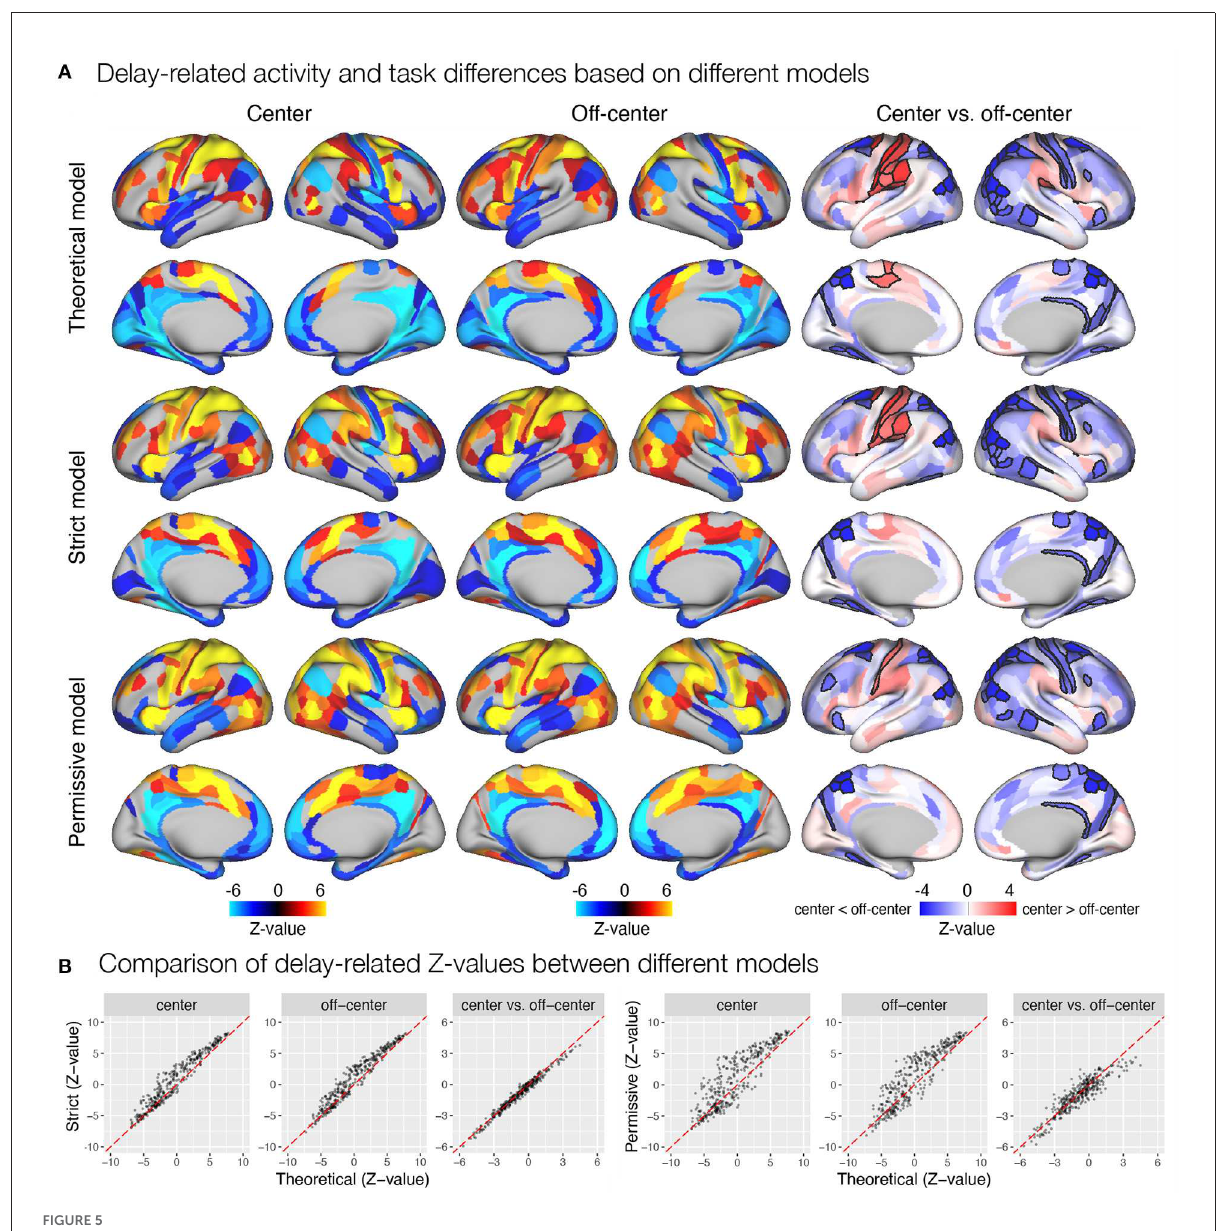
FIGURE5 Delay-related activity and differences between task conditions estimated based on different event models in the spatial working memory study. Results were obtained by modeling encoding , delay , and response , with the timing and duration of each event either theoretically determined or derived automatically based on the autohrf using less or more permissive constraints. (A) Results of the statistical analysis show delay-related activity separately for the center and off-center conditions and delay-related activity differences between task conditions. The results of activation and deactivation during individual task conditions (the first two columns) show only statistically significant results at q < 0.05. On the other hand, the task differences (the third column) are presented across all ROIs, while the black outlines mark statistical significance at q < 0.05. (B) The comparison of Z -values of individual ROIs between different models. Each dot represents the Z -value for a single parcel obtained with the contrasted models. The dashed red line represents the